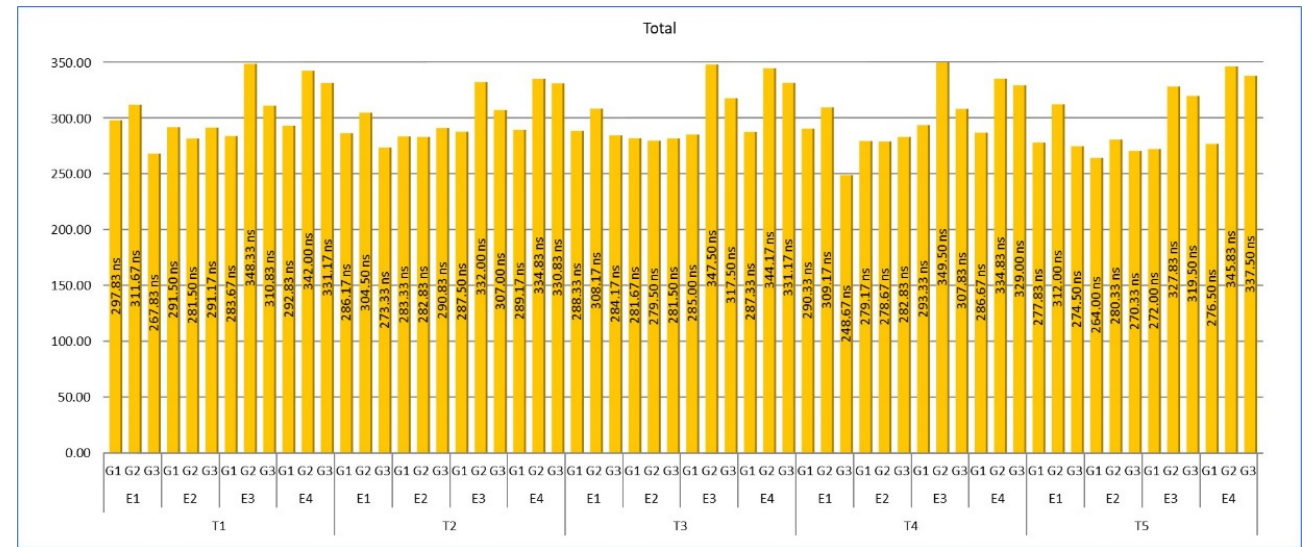
Figure 3. Effects of genotypes (G), Year–location interaction (E) and defoliation (T) on 1000-kernel weight (KW), seed germination (GR) and variations in means by the application of ANOVA, ns—non significant.